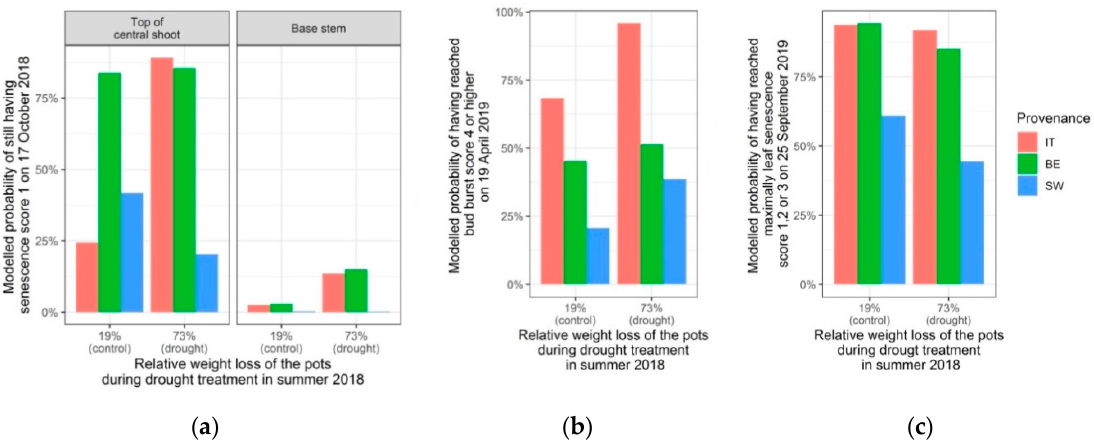
Figure 10. Modelled scoring of the phenophases, depending on the provenance and on the relative weight loss of the pots. ( a ) Post ‐ drought leaf senescence in 2018 scored on two locations of the plant: the top of the central shoot and the base stem; ( b ) Bud burst in 2019 scored on the top of the central shoot; ( c ) Leaf senescence in 2019. IT: Italian provenance, BE: Belgian provenance, SW: Swedish provenance.